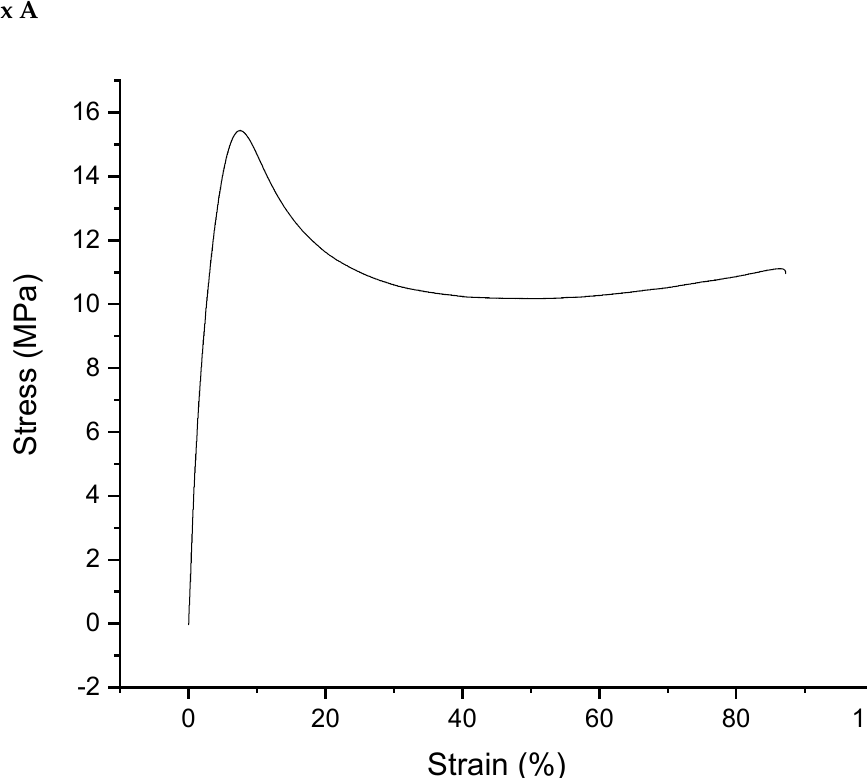
Molecules 2019 , 24 , 3597 Figure A1. Stress–strain diagram of a tensile measurement of the urea-crosslinked copolymer network.